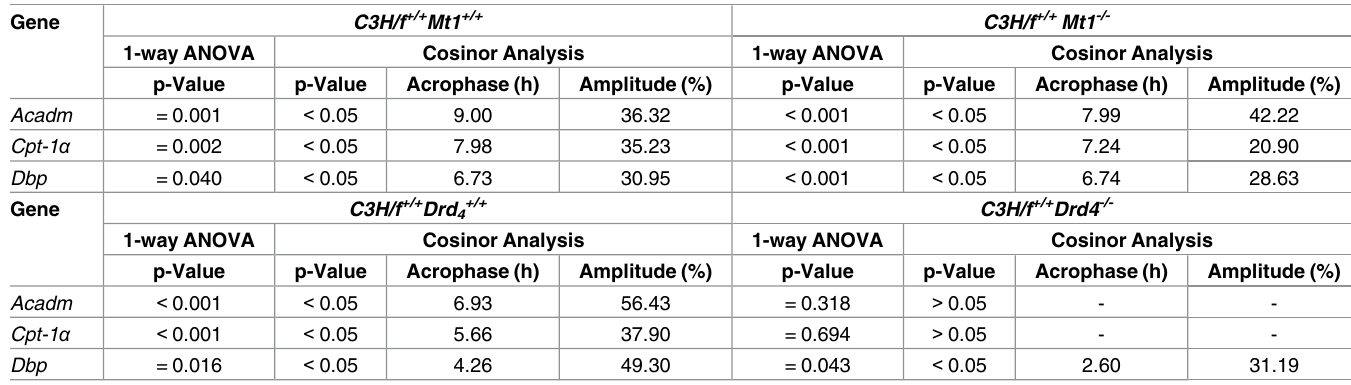
Table 3. Statistical analysis of transcriptional profiling illustrated in Fig